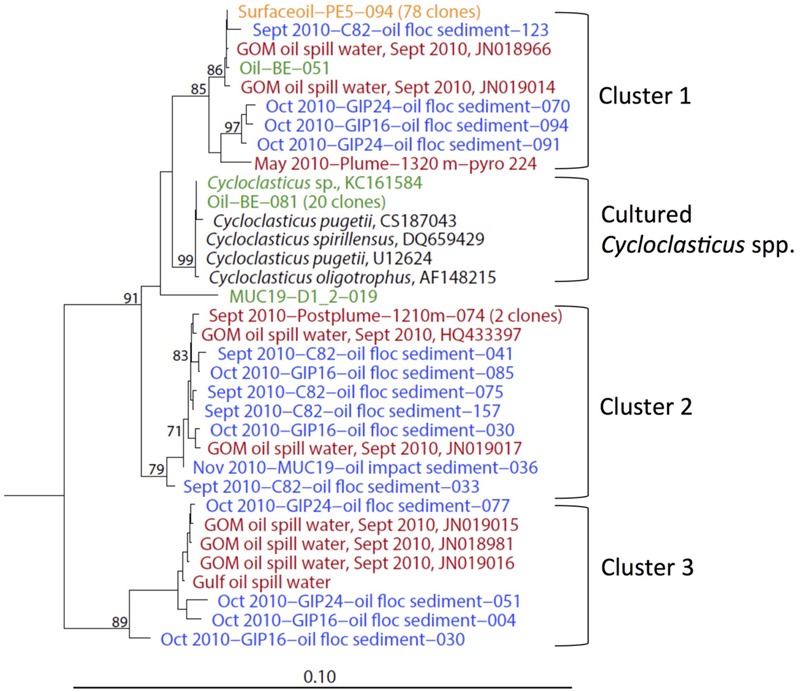
16S rRNA gene phylogenetic tree of Cycloclasticus sequences derived from both water column and the surficial sediment of the Gulf of Mexico at various time points. The orange-colored clone is from May 2010 surface oil slick; red clones are from post-plume water (Valentine et al., 2010; Redmond and Valentine, 2012; Yang et al., 2016); blue clones are from surficial sediments of September, October and November 2010; green clones represent phylotypes and a new strain from oil slick incubations (Gutierrez et al., 2013) and 4°C enrichments (Yang, 2014).